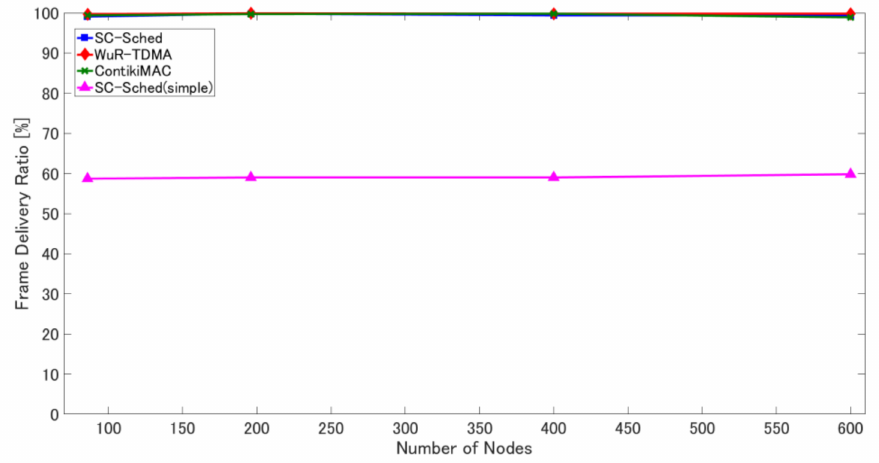
Figure 7. Frame delivery ratio in the four methods under different numbers of sensor nodes.